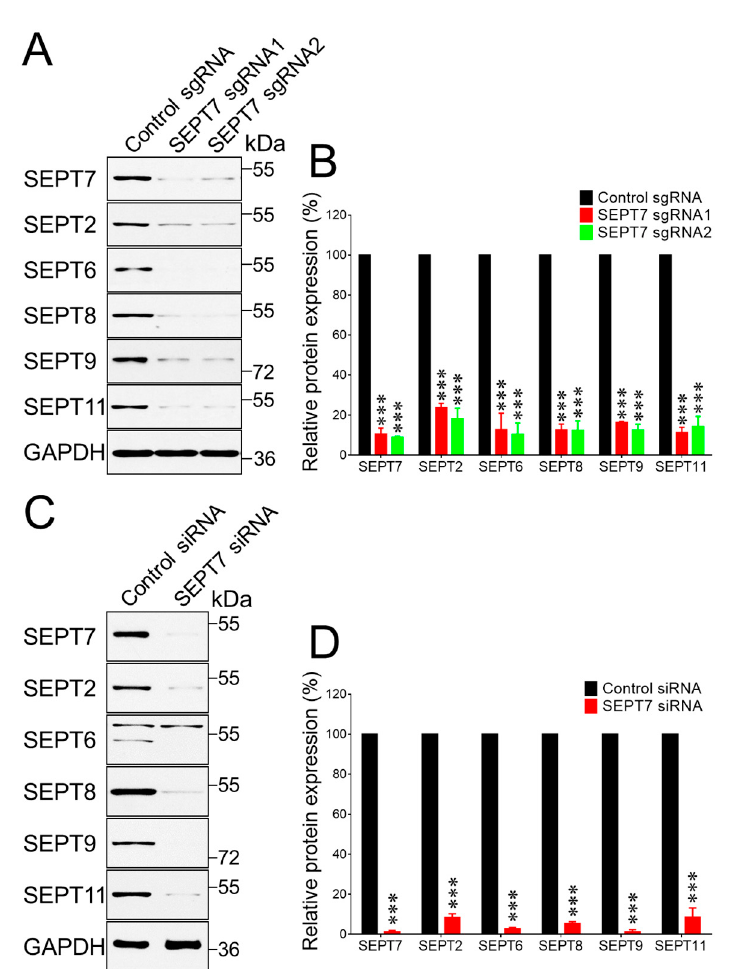
Figure 3. Either CRISPR/Cas9-mediated knockout or siRNA-mediated knockdown of SEPT7, markedly decreases the expression of other septin proteins in epithelial cells. SEPT7 was either knocked out in HT-29 cells using CRISPR/Cas9 mediated gene editing using two different single guide RNAs (sgRNA1 and sgRNA2, A , B ) or knocked down in DU145 cells using a siRNA SmartPool ( C,D ). Representative immunoblots ( A , C ) and densitometric quantification of septin expression ( B , D ) are shown. Data are presented as a mean ± SE ( n = 3); *** p < 0.001.